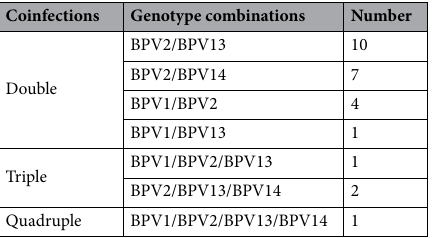
Table 2. Genotype coinfections with related number of their combination are